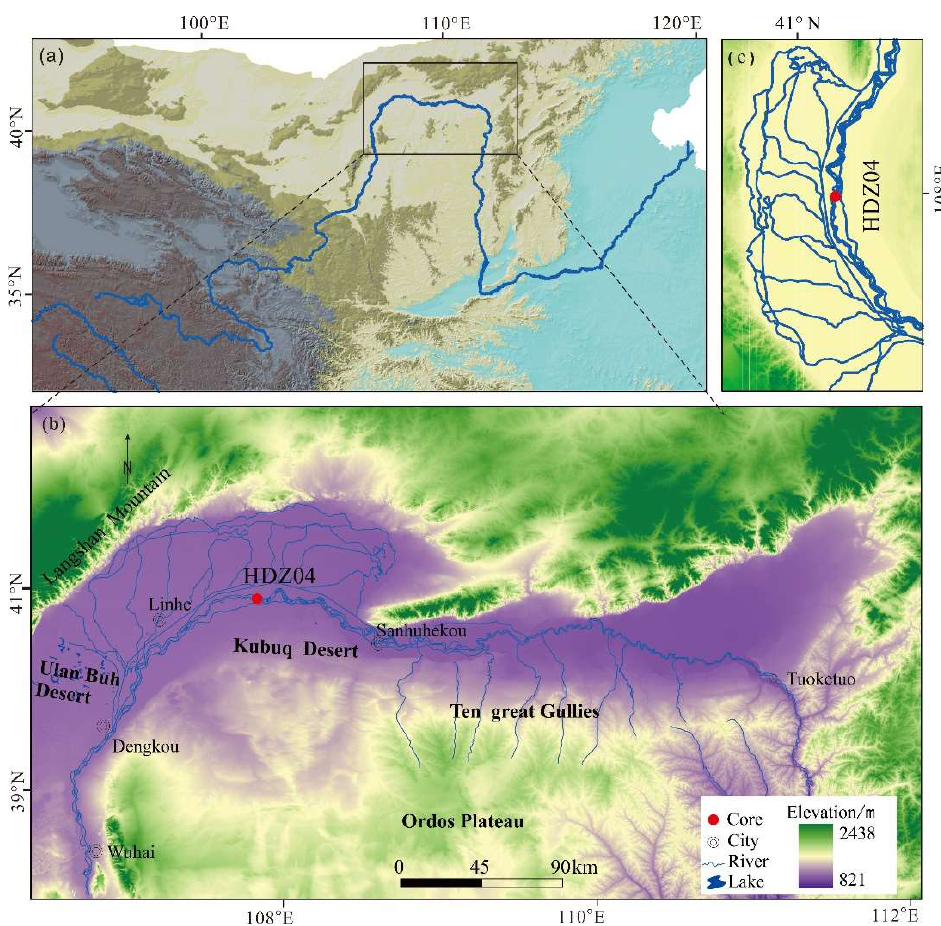
Figure 1. Geographic map of the Yellow River ( a ). A map showing the location of the Houtao section of the upper Yellow River ( b ). Site of core (HDZ04) (c).